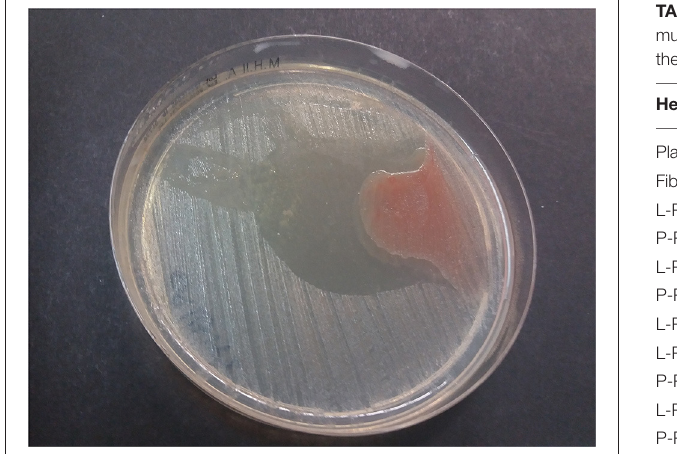
FIGURE 1 | L-PG 500 µ l effect against susceptible K. pneumoniae ssp. pneumoniae strain after 4h at 37 ◦ C aerobically.